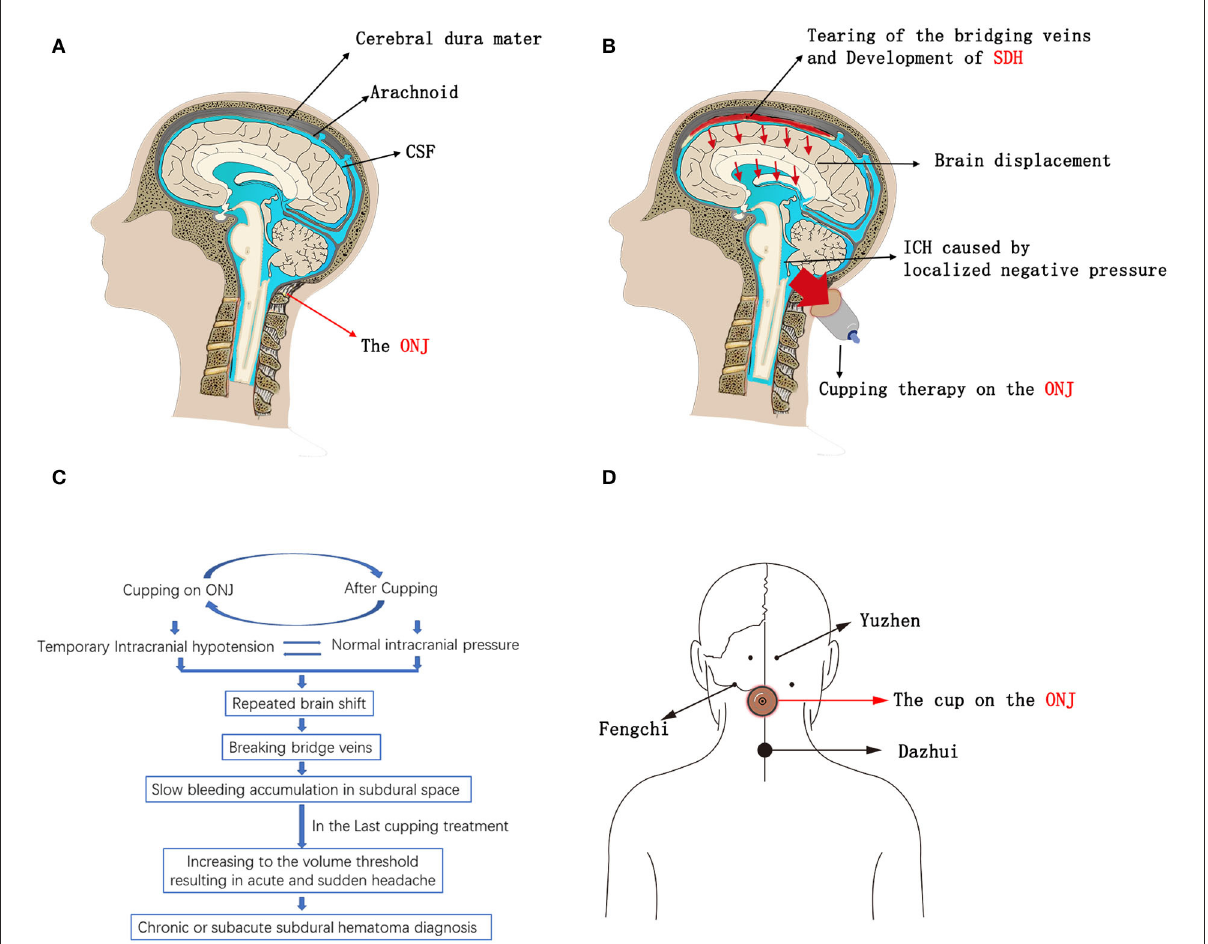
FIGURE1 (A–C) Schematics of SDH development due to the substandard Cupping therapy on the ONJ. (D) Schematics of the most common anatomical sites that are close to the ONJ in traditional Chinese cupping therapy; Yuzhen (near the external occipital protuberance), Fengchi (near the base of the occiput), and Dazhui (near the seventh cervical vertebra). CSF, Cerebrospinal Fluid; ONJ, Occipital-neck Junction; SDH, Subdural Hematoma; ICPR, Intracranial Pressure